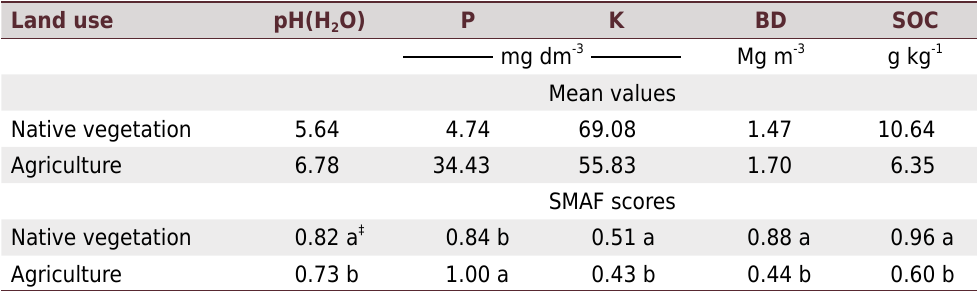
Table 2. Mean values and SMAF scores of soil quality indicators for the 0.00-0.20 m layer in a native vegetation and long-term agriculture